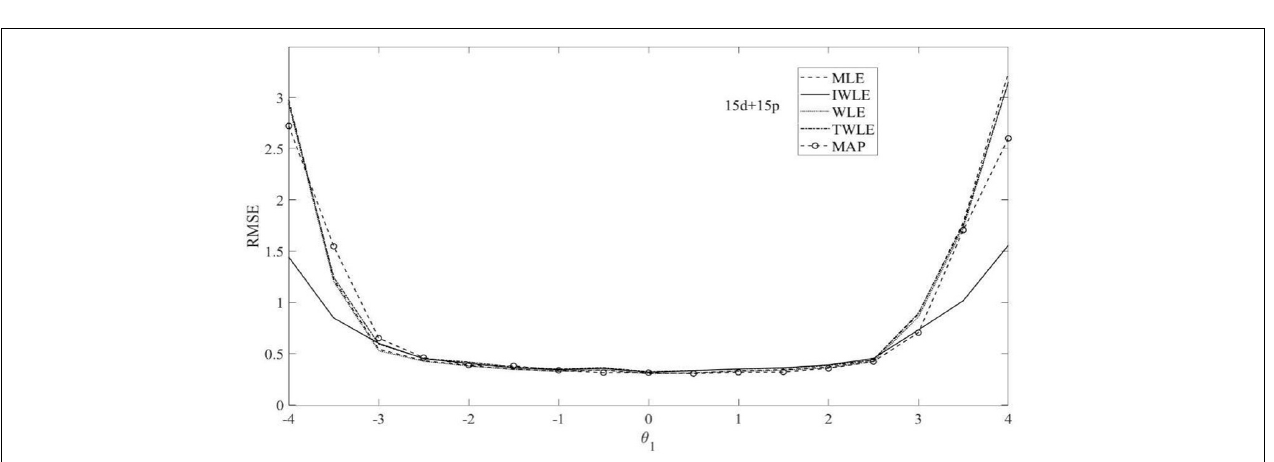
FIGURE 4 | RMSE of the five θ 1 estimation methods MLE, MAP, IWLE, WLE, and TWLE for 15d+15p.